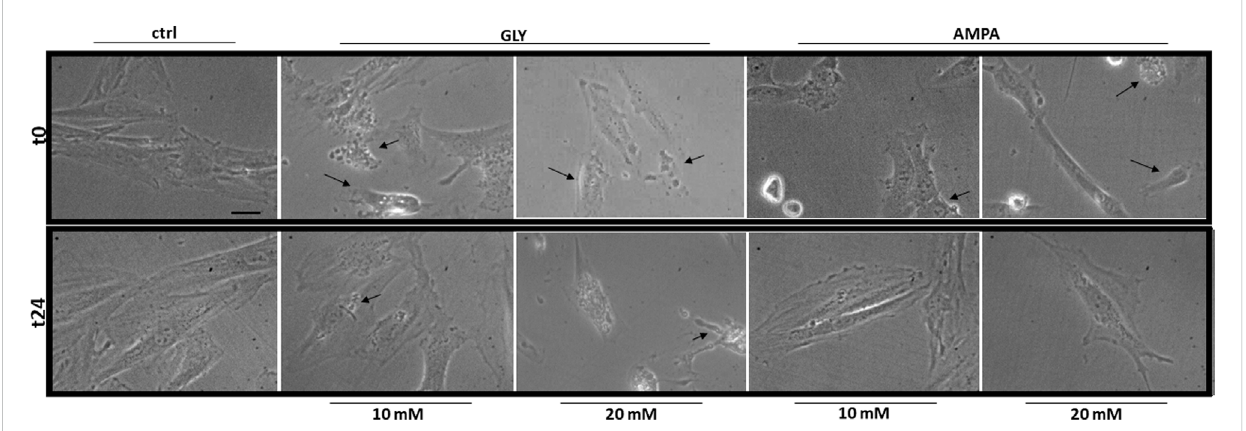
FIGURE 2 Morphology. The fi gure shows representative fi elds of H9c2 cells treated with 10 or 20 mM of glyphosate (GLY) or AMPA for 24 h. Images were acquired through acameraconnected to an invertedmicroscopeatthestart (t0 — top panels)and attheend (t24 — bottom panels)ofthetreatmentswith a 63X lens (scale bar = 10 µm).